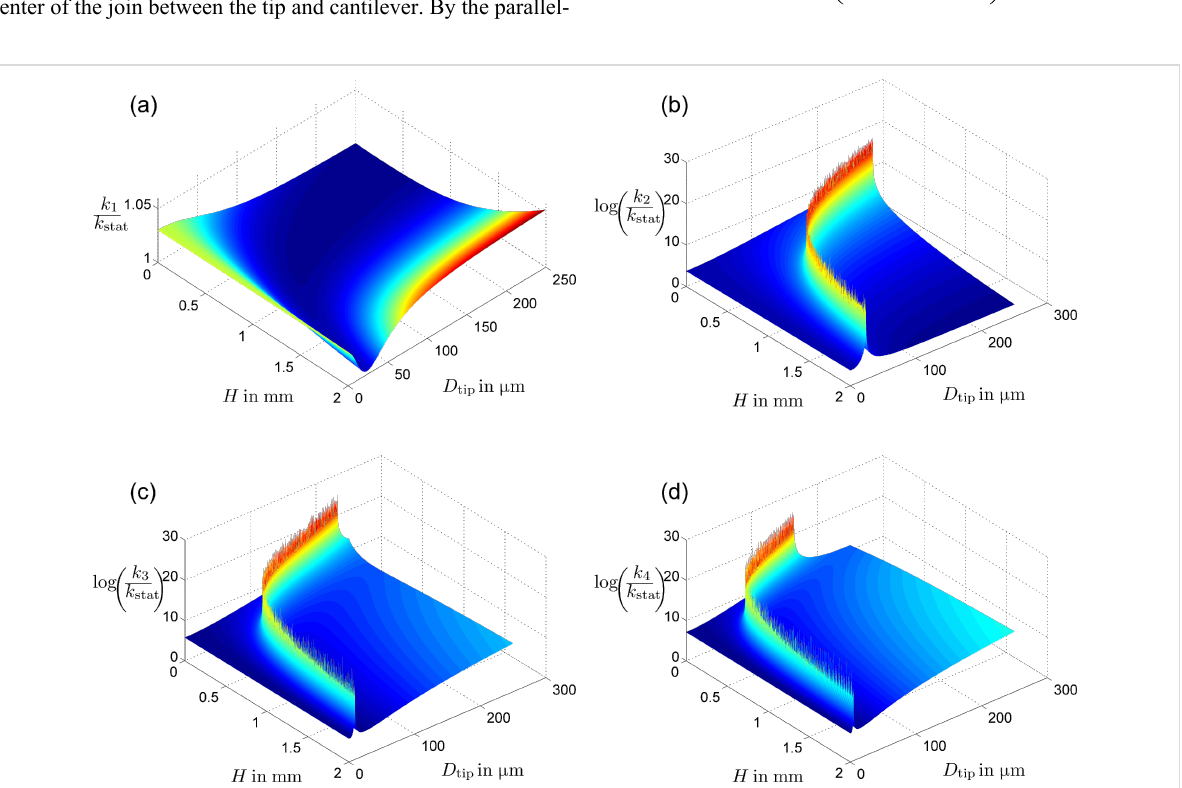
Figure 2: The ratio of dynamic spring constants k n to the cantilever static spring constant k stat for n = 1,2,3,4, plotted for a range of tip lengths and diameters. The sudden increases in the higher eigenmodes result from nodes positioned at the end of the tip resulting in infinite spring